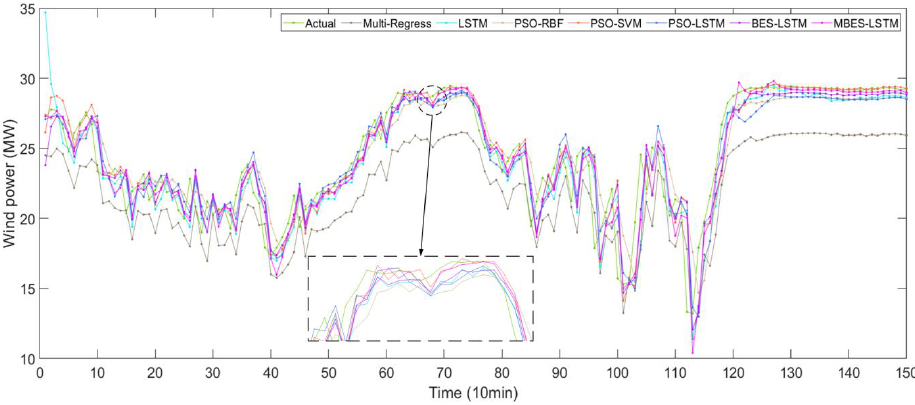
Figure 6. The forecasting results of different models.